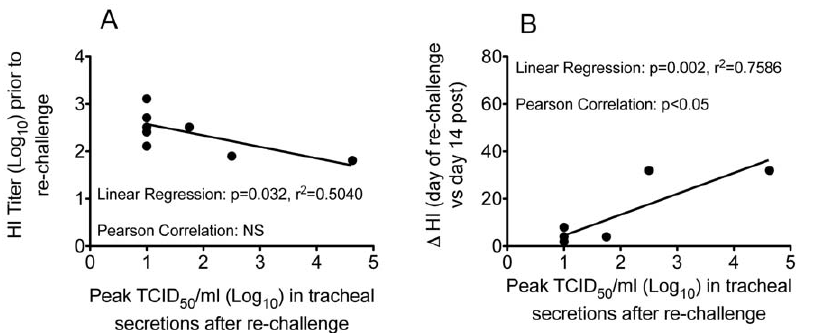
Figure 5. Correlation between serum HI titers and influenza virus replication in the lower respiratory tract after A/Memphis/7/01 re- challenge. A) HI titer on day of re-challenge and peak infectious virus titer in tracheal secretions after re-challenge. B) Fold change in HI titer from the day of re-challenge to 14 days later and peak infectious virus titer in tracheal secretions after re-challenge.